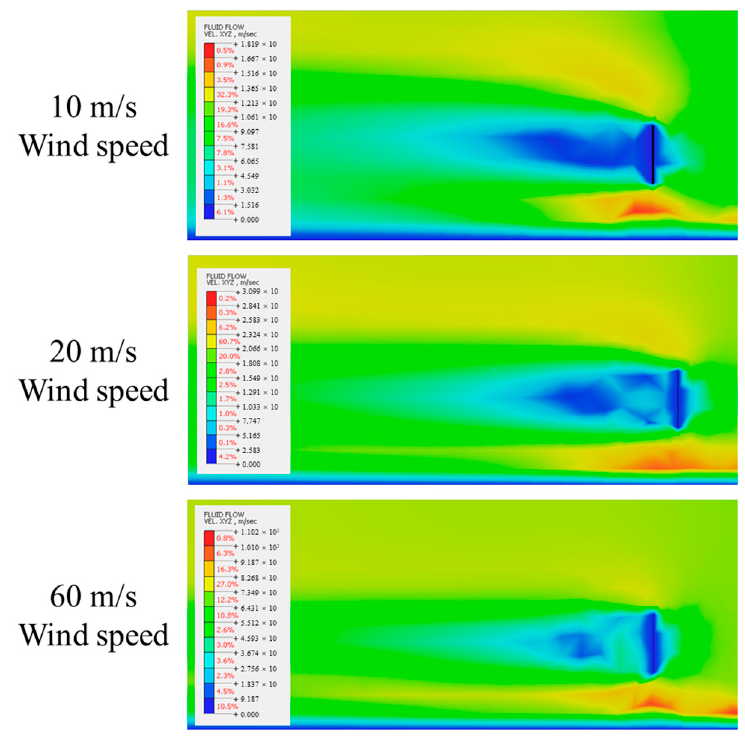
Figure 10. Wind pressure distribution of perforated road sign by wind speed.